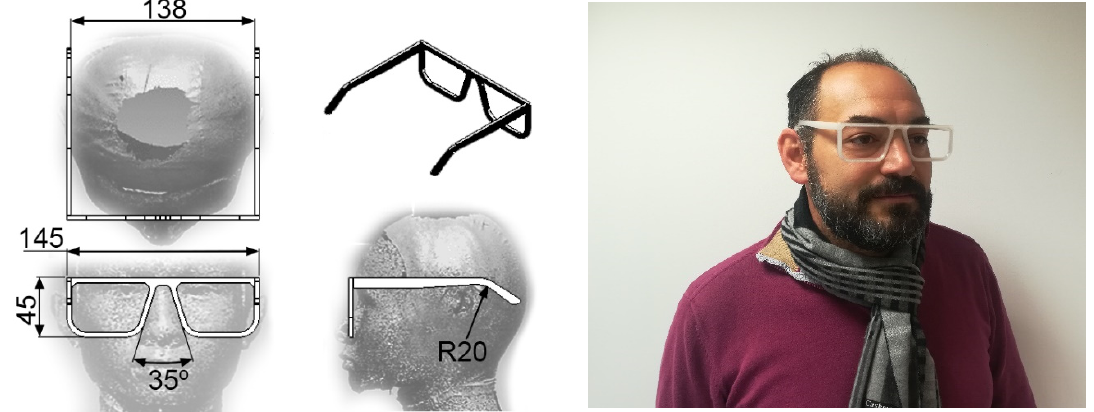
Figure 13. Customized frame glasses: parameterized distances (left); real frame glasses produced in PLA via FDM (F = 110%; LH = 0.16 mm) (right).